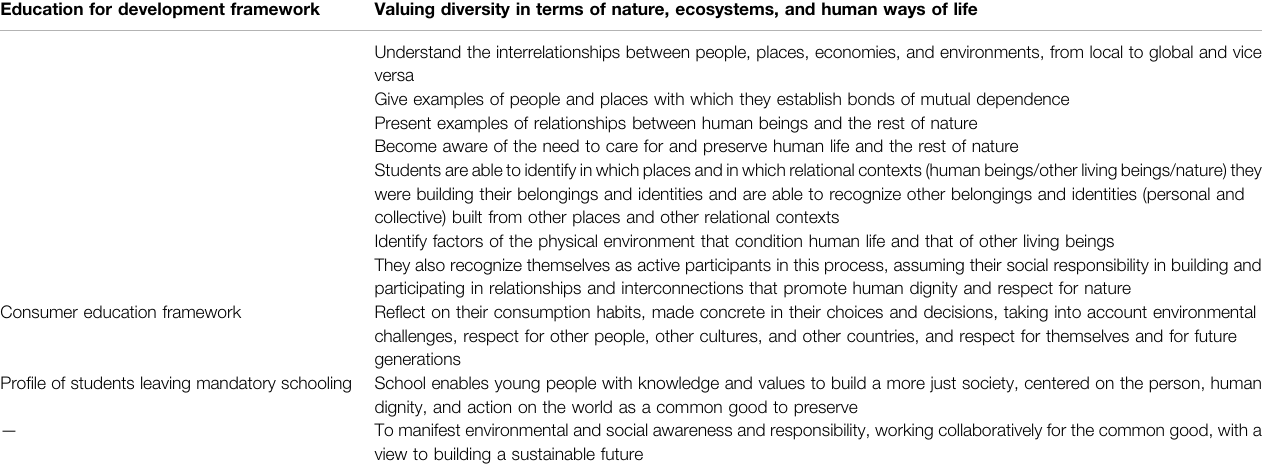
TABLE 6 | Explicit translated references in the documentary corpus to biocultural diversity and sustainable development. Education for development framework Valuing diversity in terms of nature, ecosystems, and human ways of